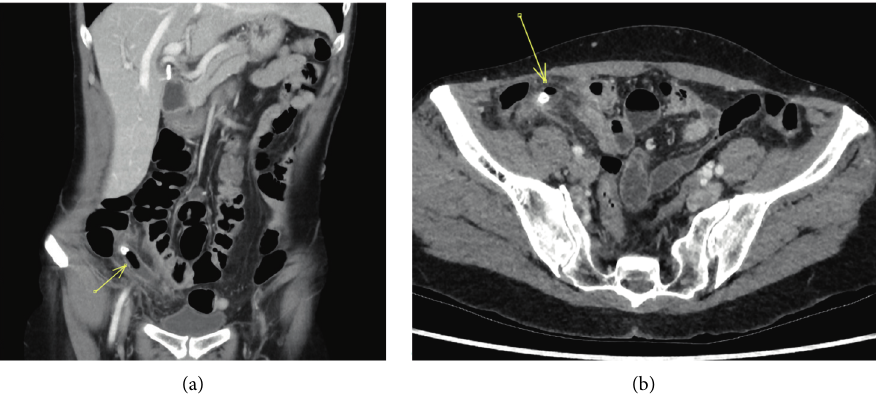
Figure 2: A 58-year-old woman with clinical suspicion of acute appendicitis. Coronal (a) and axial (b) CT abdomen in the portal venous phase shows a distended appendix with periappendiceal fat stranding. There is intraluminal gas adjacent to the appendicolith towards the tip. Gangrenous appendicitis was confirmed on subsequent histopathology report and